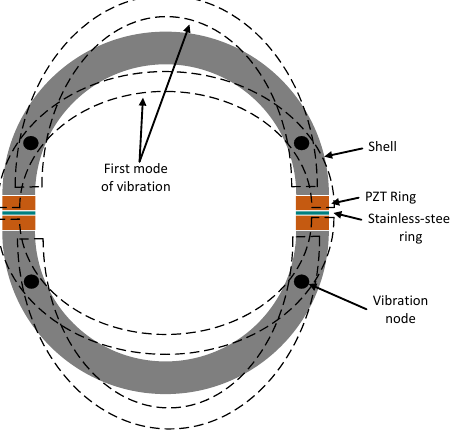
Figure 1. The 2D model of the transducer and its first mode of